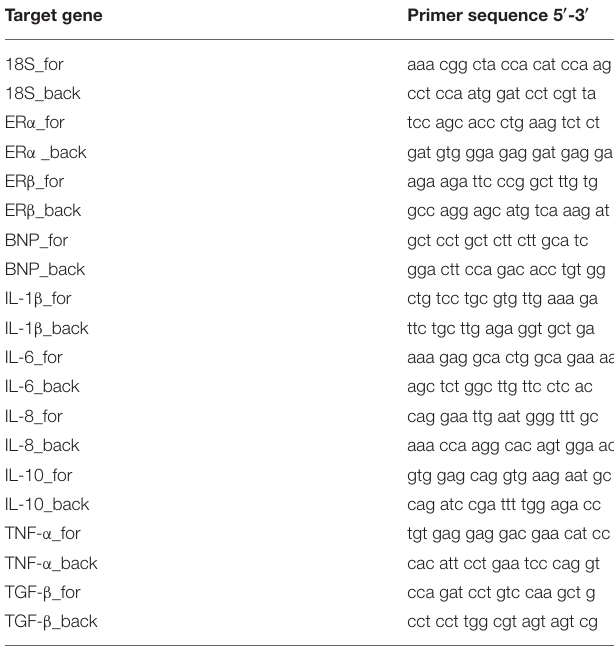
TABLE 2 | Specific human primers used for